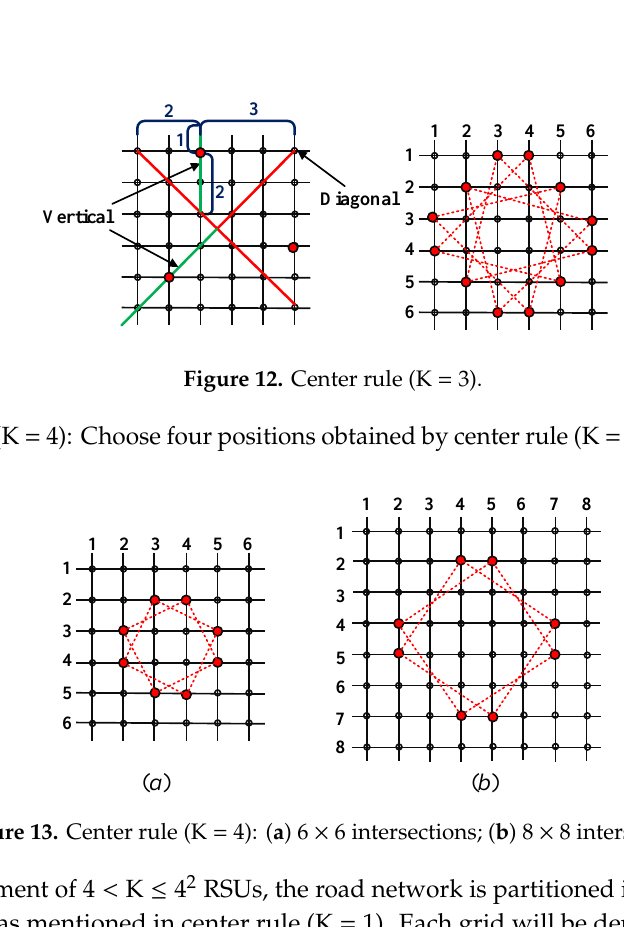
Figure 11. Center rule (K = 2): ( a ) 6 × 6 intersections; ( b ) 8 × 8 intersections.